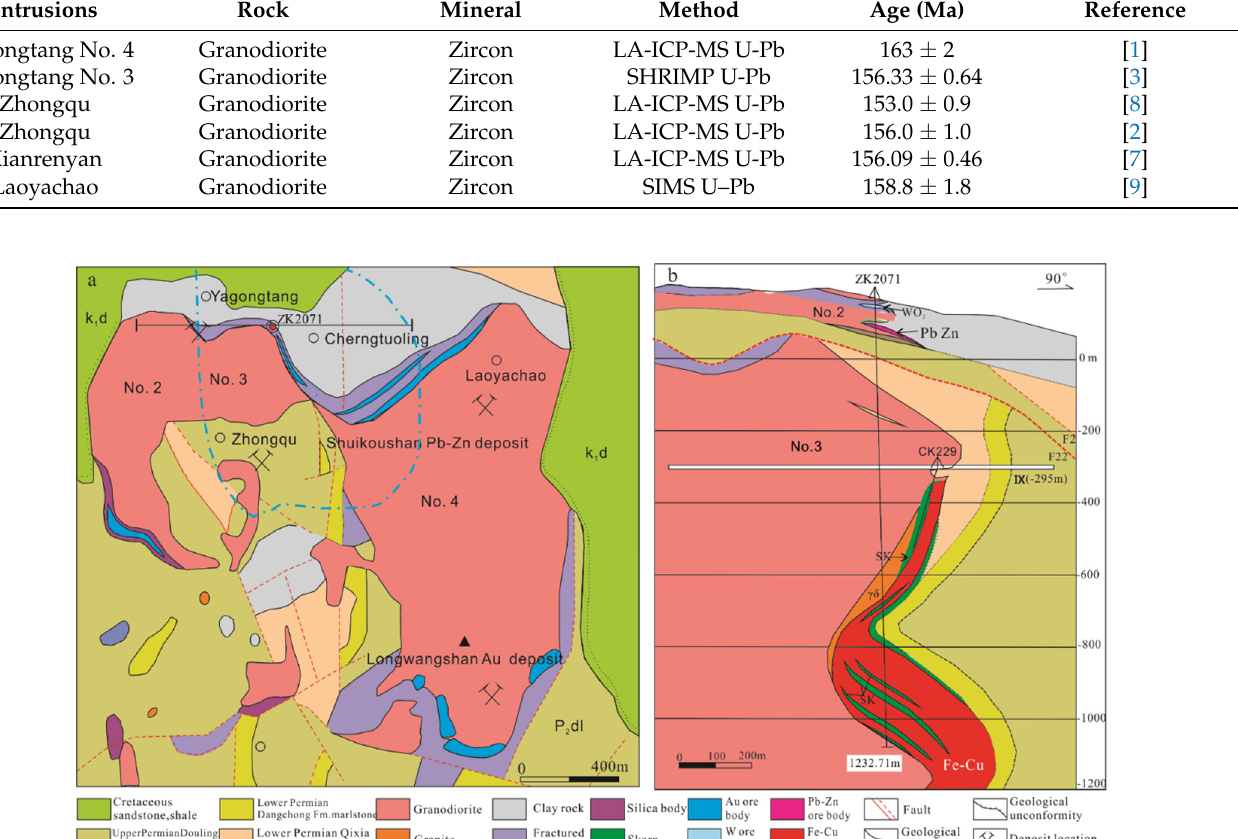
Figure 2. ( a ) Geologic map of the Shuikoushan deposit showing locations of different intrusions and country rocks (Modified from [20]). The concealed No. 3 granodiorite is projected on the surface (outlined by a blue dashed curve), the No. 2 and No. 4 granodioritic bodies are located at the western and eastern sides of the deposit, respectively, and are separated by a fault. ( b ) Cross-section of line 207 in the Shuikoushan deposit. Locations and shapes of the Pb-Zn and Fe-Cu ore bodies are displayed in this figure. The Pb-Zn ore body is distributed mainly along the contact zone between the No. 2 granodiorite and fractured limestone, whereas the Fe-Cu ore body is distributed along the contact zone between the No. 3 granodiorite and Lower Permian Qixia limestone, note that several lenses of skarns are seen within the Fe-Cu ore body.